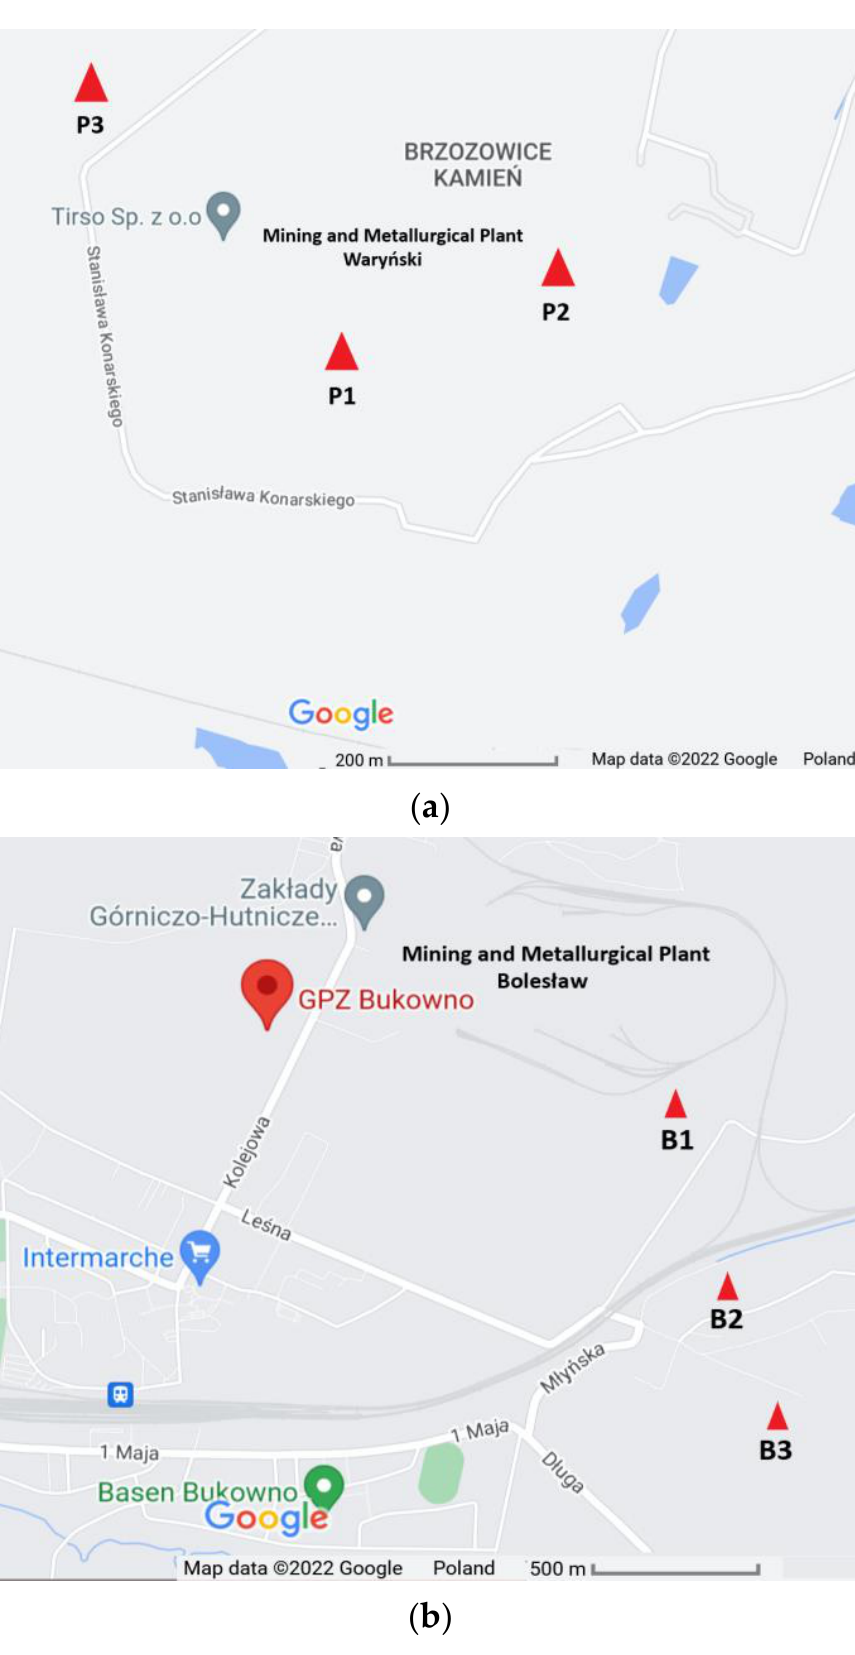
Figure 1. Sample site geographical location in ( a ) Piekary Śląskie, and ( b ) Bukowno, Poland (source: https://www.google.pl/maps, modified, 21 July 2022).